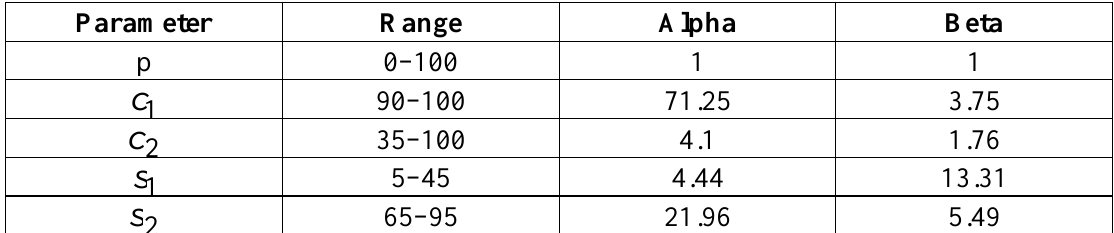
Table 22. Prior information about stool and serology tests.